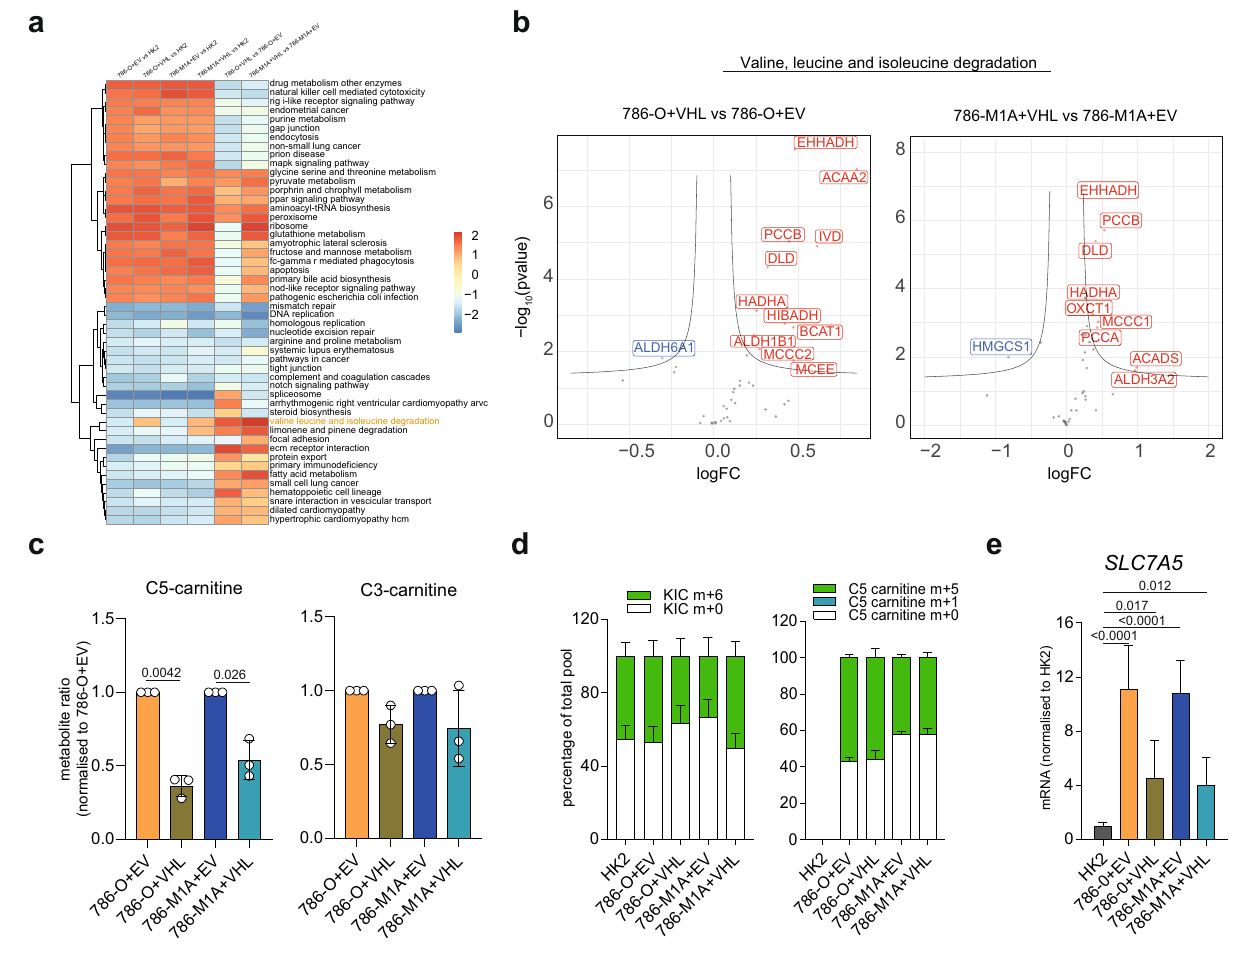
Fig.5|VHLreconstitutionrestoresBCAAfunctioninginccRCCcells.a Heatmap showing the enriched pathways in the indicated comparisons obtained through GSEA analysis of proteomics data generated from cells grown in RPMI. b Volcano plot showing the differential expression of proteins that belong to KEGG “ Valine leucine and isoleucine degradation ” signature in 786-O+VHL vs. 786-O+EV and 786-M1A+VHL vs. 786-M1A+EV from proteomics data obtained culturing cells in RPMI. FC fold-change, red=upregulated proteins, blue=downregulated proteins. c Ratio of the intracellular abundance of C3-carnitines and C5-carnitines in cells expressingVHLcomparedtoEVculturedinRPMI.Datawerenormalizedtototalion count and represent the mean of 3 independent experiments ( N =3)±S.E.M. p -